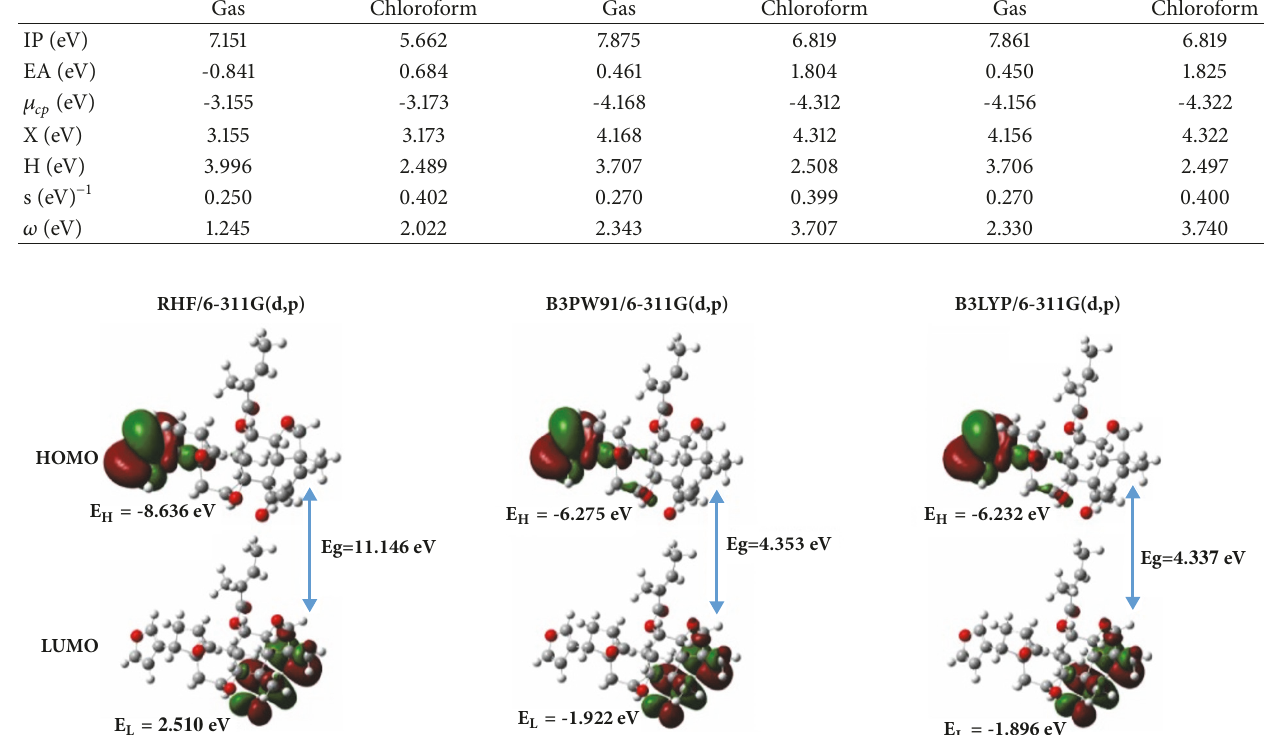
Figure 3: Molecular orbital and the HOMO and LUMO energy of Rubescin E in gas